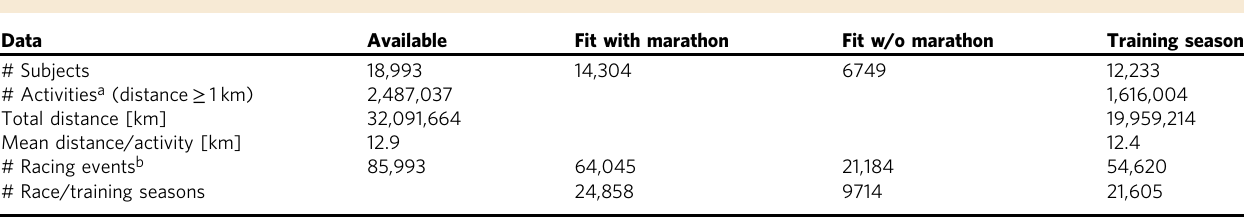
All data were collected through the PolarFlow web service 48 . a After removal of unrealistic average velocities (faster than world record). b Distances are 5km, 10km, half-marathon, and marathon depending on the model fi t (w or w/o marathon). c Seasons with # runs ≥